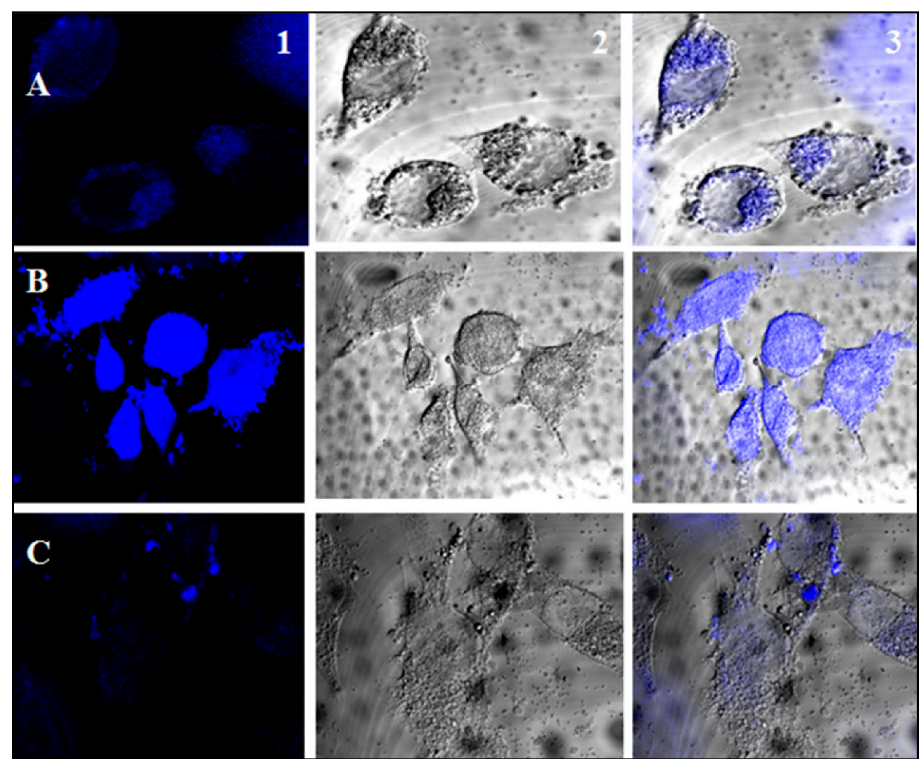
Figure 9. Confocal microscopic images of the CPQN- and quercetin-treated N2A cells. Cells treated with 5 μ g/mL CPQN for 1 h ( A ), for 24 h ( B ), and with 5 μ g/mL bulk quercetin for 24 h ( C ); 1, 2, and 3 represent blue-filtered, bright field, and overlay images, respectively. Adapted with permission from Ref. [131] . Copyright Elsevier, 2017.